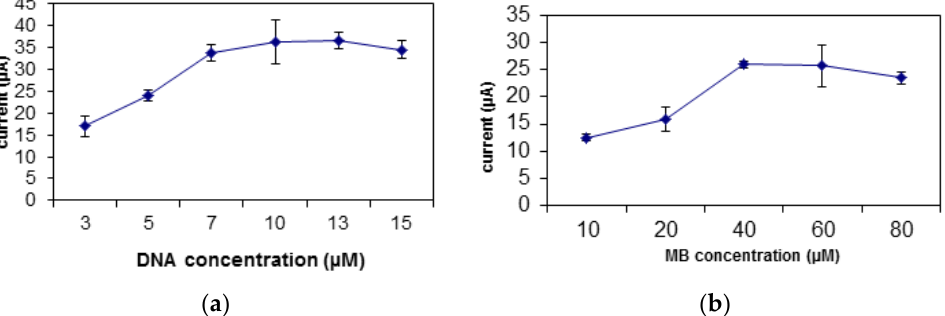
Figure 5. The optimization of the ( a ) DNA and ( b ) MB concentration to be used for the biosensor.